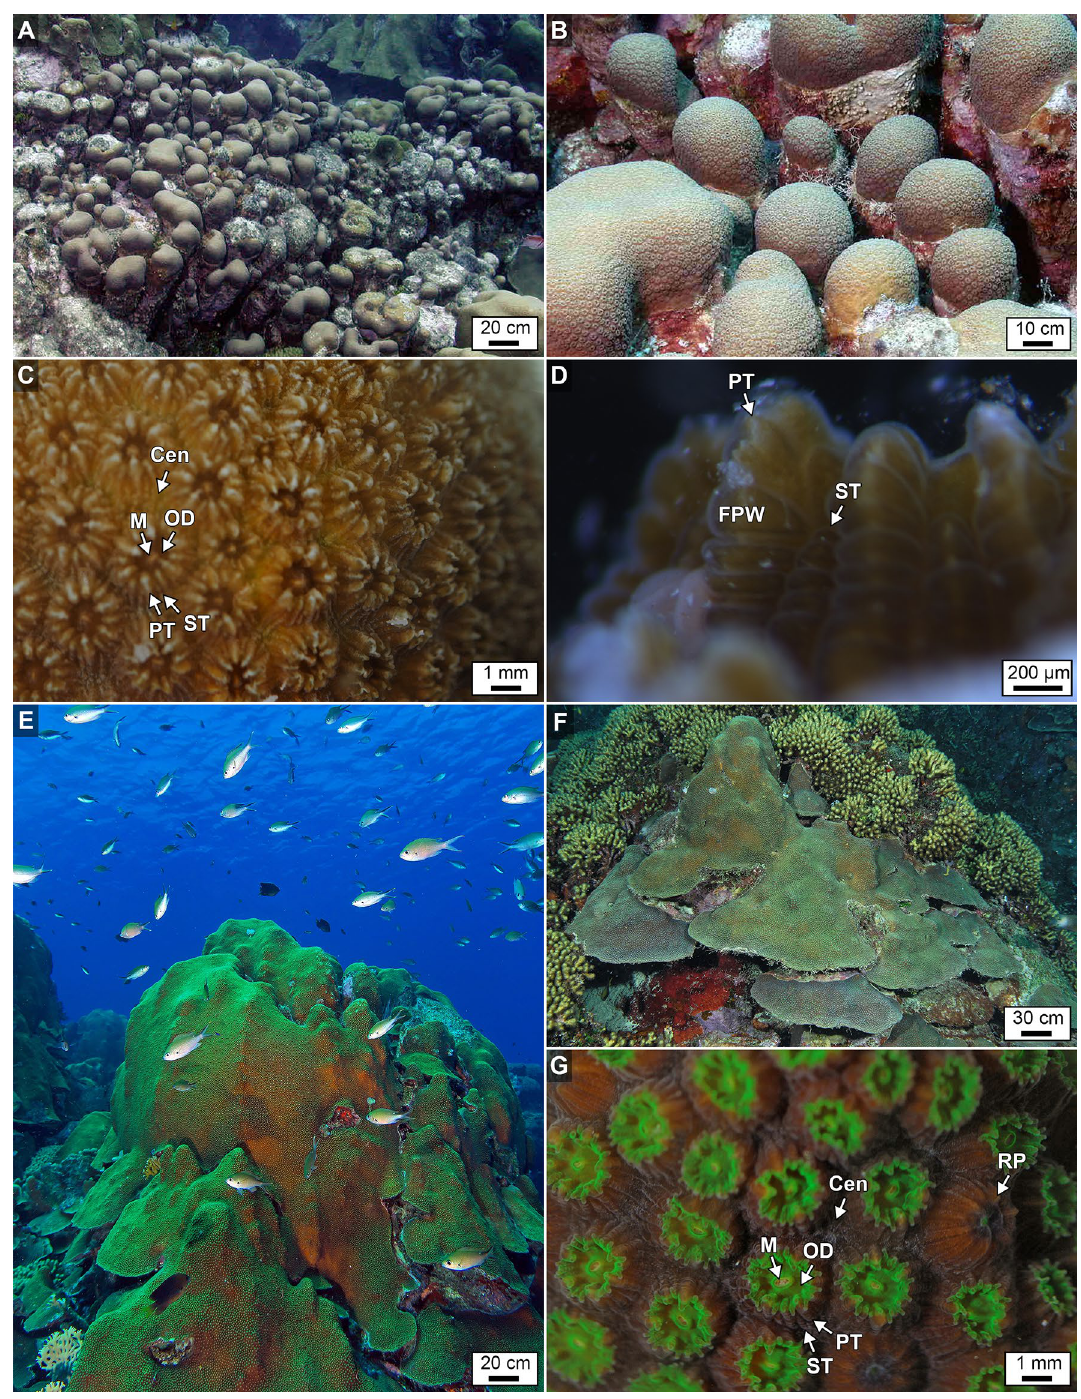
Figure 2. Field and laboratory photographs of O. annularis and O. faveolata. ( A , B ) Field photographs of O. annularis colonies at ~5 m WD at Playa Kalki exhibiting growth of individual columnar heads that are clustered together into an overall hemispherical assemblage. ( C , D ) Laboratory photographs of individual O. annularis partially opened polyps that are ~2.3 mm in diameter. ( E , F ) field photograph of O. faveolata colonies at Playa Kalki that grow as massive shapes with knobby ridges that flair out at the lowermost edges of each colony at ~ 12 m WD and broadened morphologies at ~ 18 m WD. ( G ) Laboratory photograph partially opened and partially extened polyps of O. faveolata that are ~2.4 mm in diameter. Labels in C, D and G include: Cenceonosarc; FPW_folded polyp wall; PT_ primary tentacle; ST secondary tentacle; OD-oral disk; M-mouth; and RP-retracted